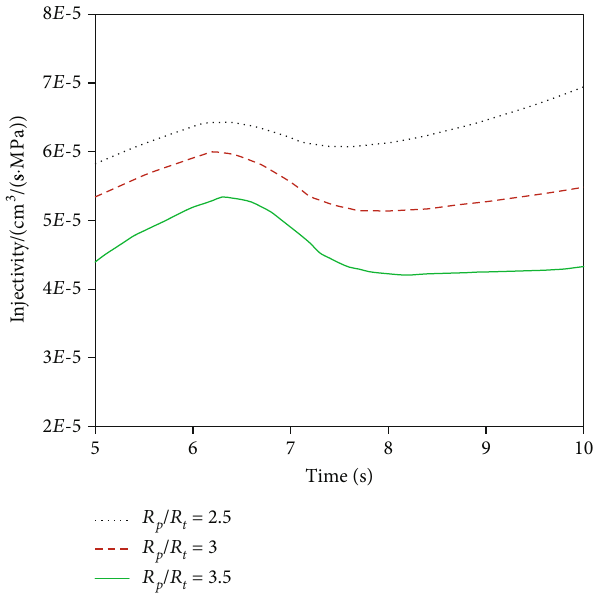
Figure 6: Injectivity change with time for di ff erent pore-throat ratio.